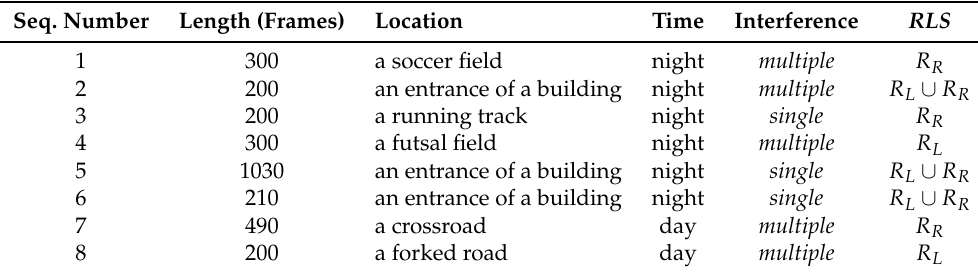
Table 1. Test video sequences for shadow